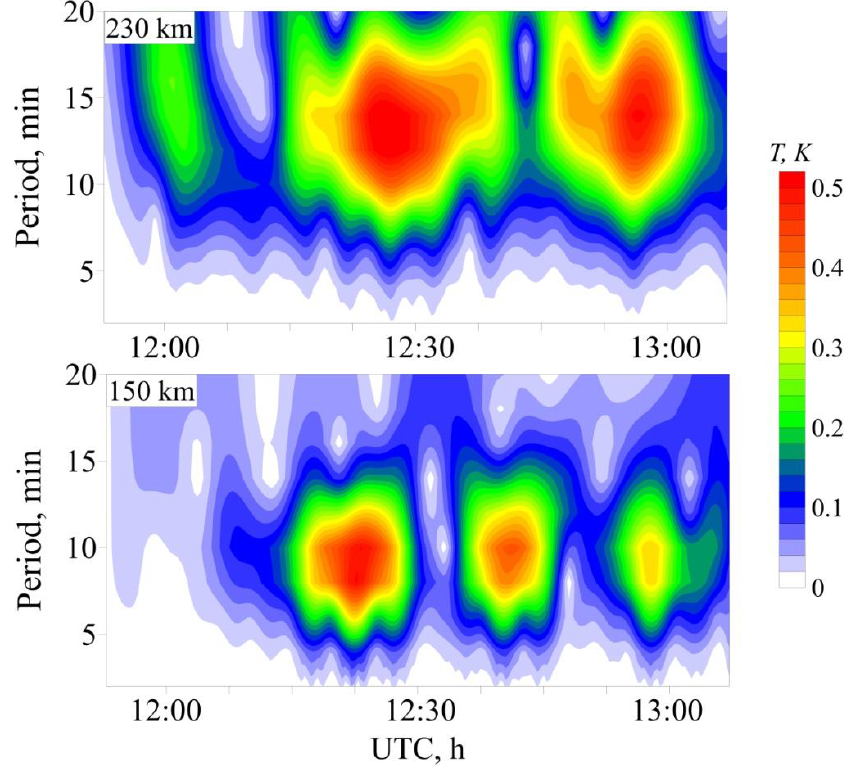
Figure 10. Frequency characteristics of temperature disturbances above the disturbance source at 150 km (lower panel) and 230 km (upper panel).